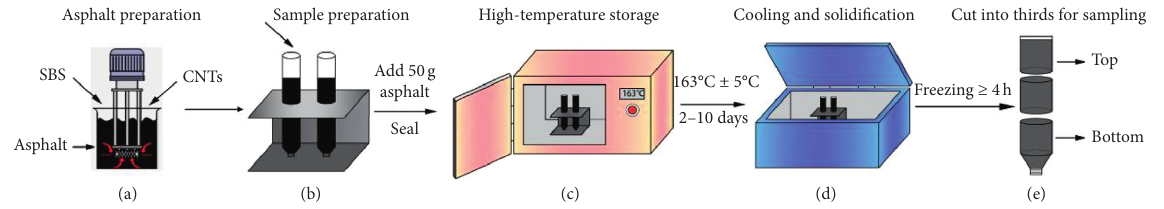
Figure 2: Segregation test of polymer-modified asphalt.